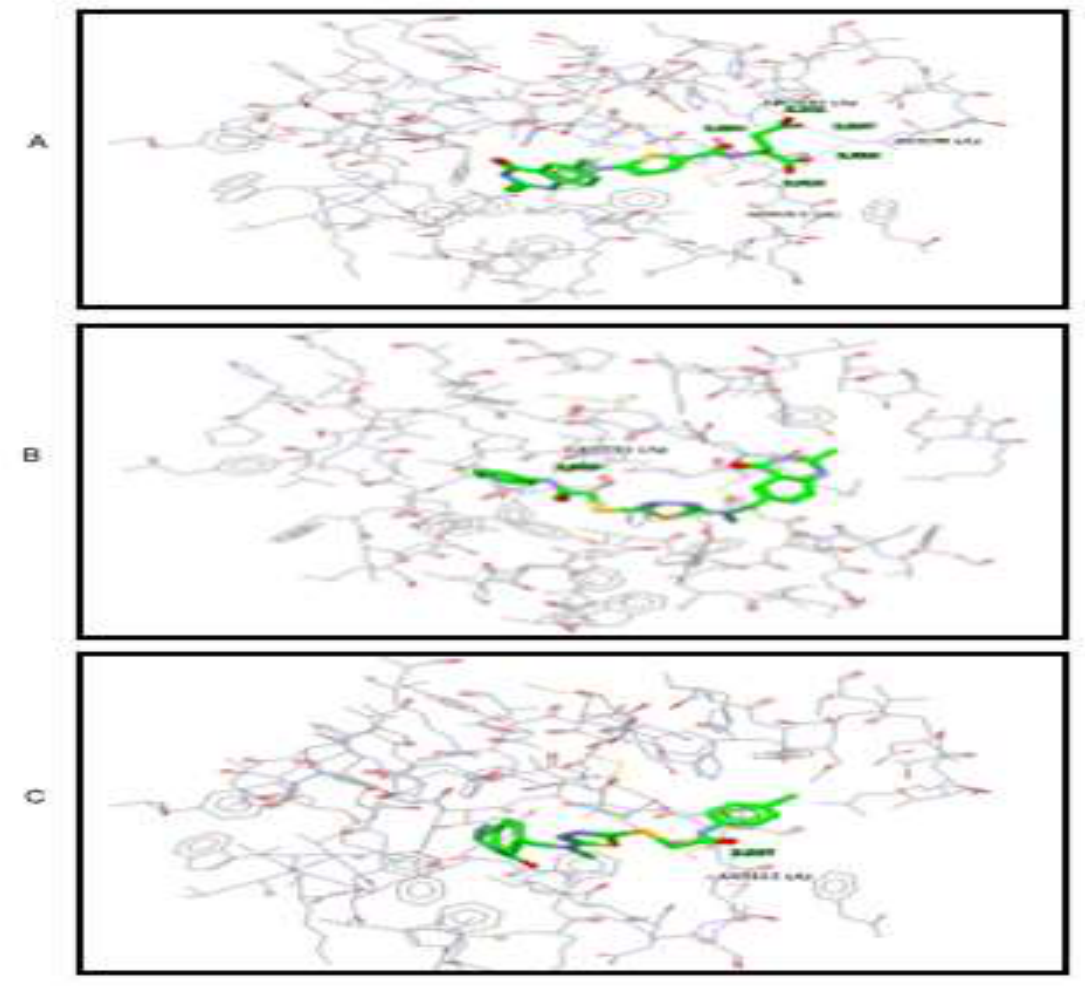
Figure 7. Comparison of binding mode of raltitrexed (A), compound S1 (B), and compound S2 (C) into the binding site of TS (PDB: 5X5Q). The key amino acid residues are represented by black sticks. Hydrogen bonds are shown as green dashes.